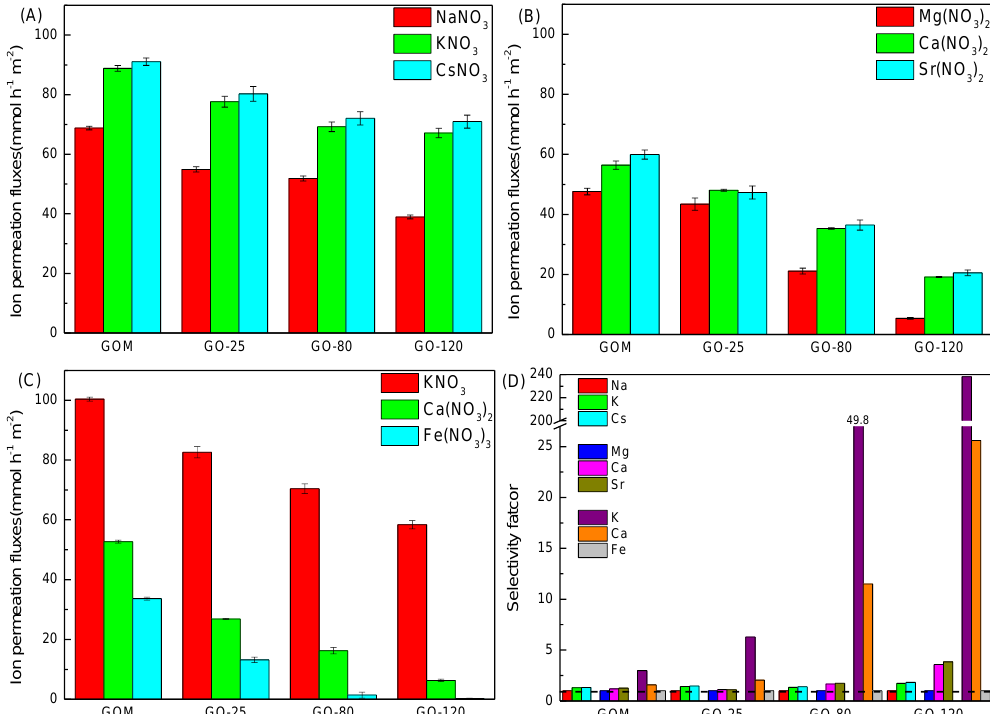
Figure 4. Ion-penetration flux ( A – C ) through GOM, GO-25, GO-80, GO-120 membrane and separation factor of cations ( D ) through GOM, GO-25, GO-80, GO-120 membrane. ( A ) NaNO 3 , KNO 3 , CsNO 3 mixed solution in feed tank, ( B ) Mg(NO 3 ) 2 , Ca(NO 3 ) 2 , Sr(NO 3 ) 2 mixed solution in feed tank and ( C ) KNO 3 , Ca(NO 3 ) 2 , Fe(NO 3 ) 3 mixed solution in feed tank; and 1.0 mol / L HNO 3 in permeate tank in A, B, and C; [M] = 0.02 mol / L, t = 12 h.